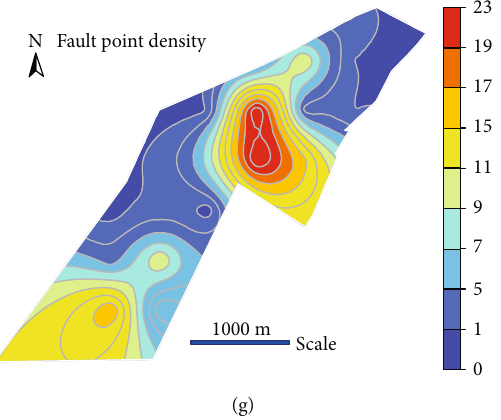
Figure 4: Thematic map of multiple geological factors for the water- fi lled aquifer in the no. 8 coal seam